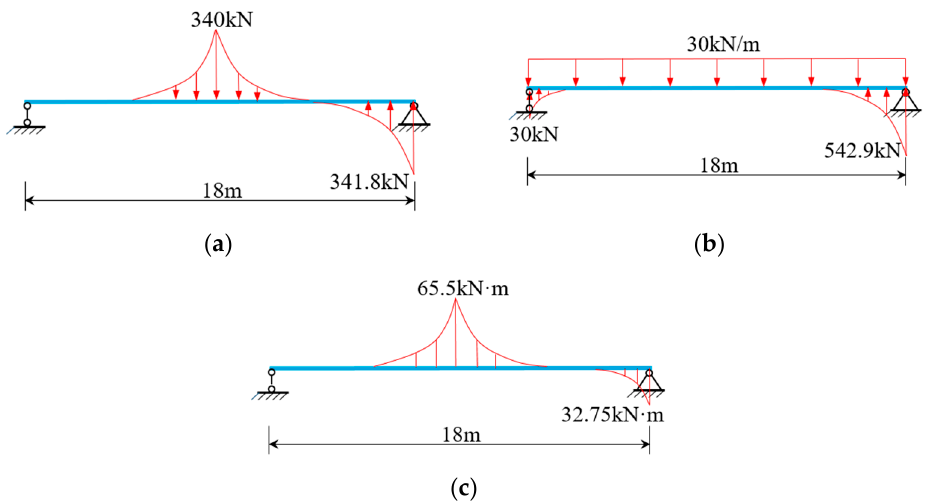
Figure 9. Equivalent distributed load of two-span continuous beam under different load cases: ( a ) Case 1; ( b ) Case 2; ( c ) Case 3.